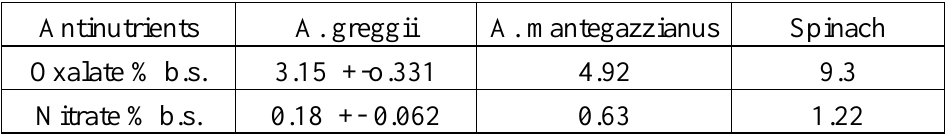
Table 2. Antinutrients of the tested A. greggii , confronted with A. Mantegazzianus and spinach.